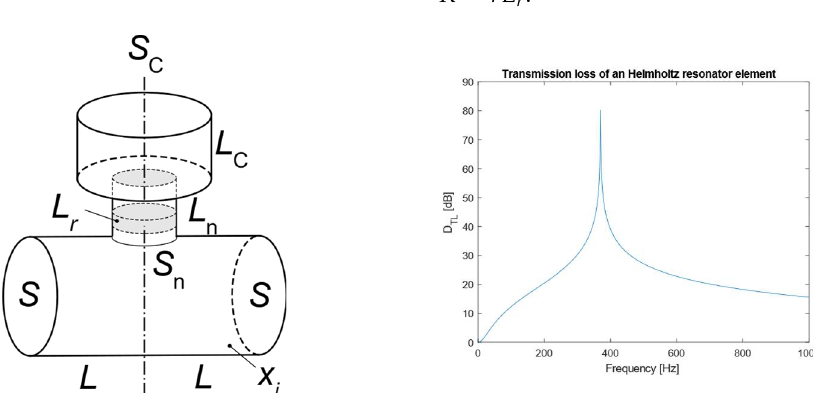
Figure 6. Helmholtz resonator sketch ( left ) and example of TL obtained with TMM ( right ). The T-matrix is calculated with (12), where the side-branch acoustic inlet impedance, Z s , is obtained from Equations (18) and